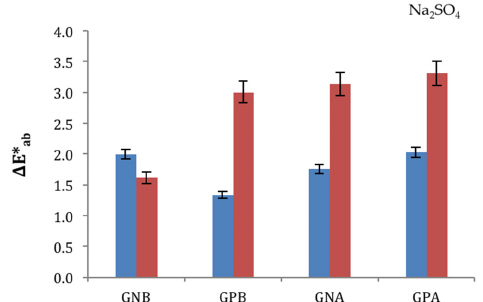
Figure 9. Total colour changes ( Δ E * ab ) due to accelerated ageing induced by NaCl and Na 2 SO 4 salt cycles. Blue bars represent the differences after seven cycles. Orange bars represent the differences after 14 cycles. The sample codes are explained in Table 1.